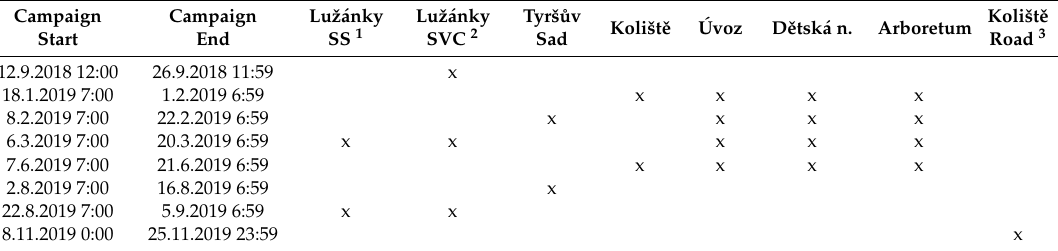
Table 2. The measurement times related to the localities.